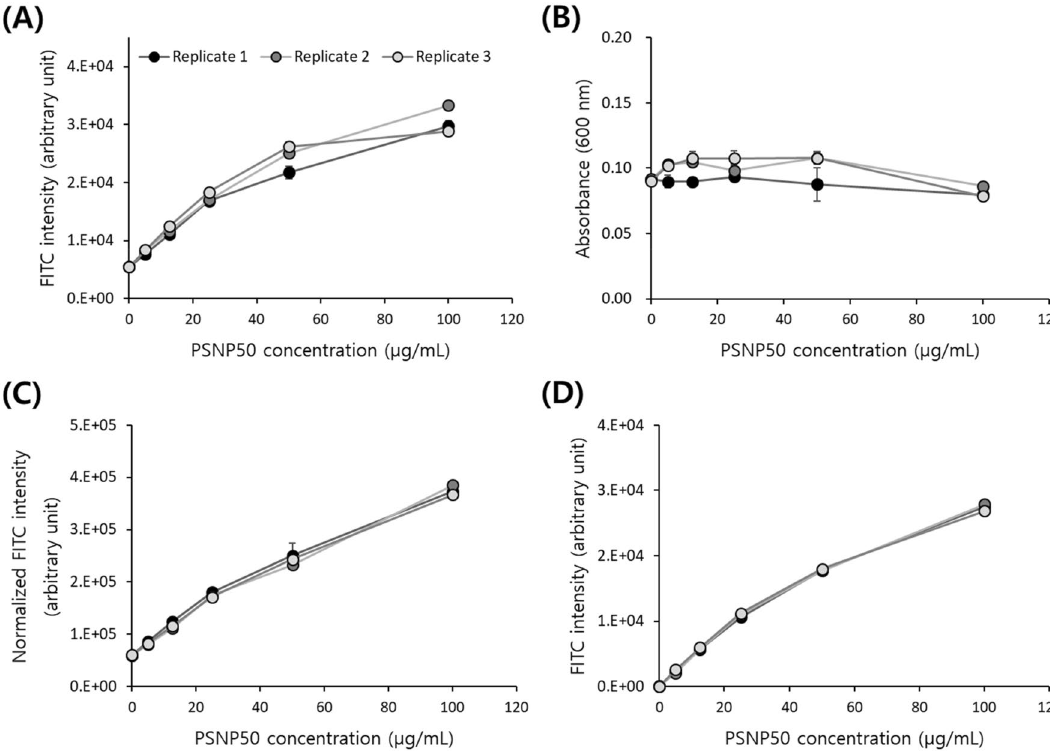
Figure 3. Quantification of nanoparticle uptake by Jurkat cells for biological replicates. The scatter plots show three biological replicates of Jurkat cells treated with different concentrations of PSNP50. ( A ) FITC intensity measured by a plate reader, ( B ) optical density measured at 600 nm by a plate reader, ( C ) normalized FITC intensity by the optical density, and ( D ) FITC intensity measured by a flow